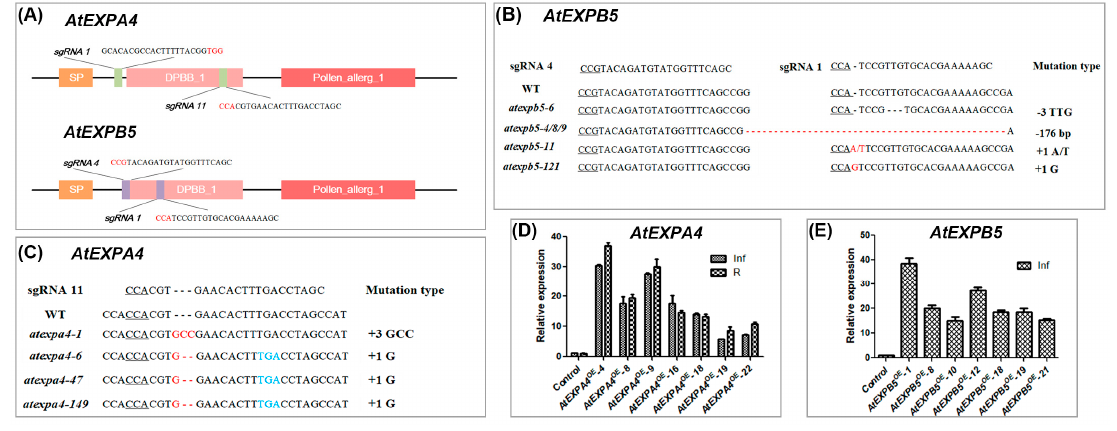
Figure 3. Confirmation of AtEXPA4 and AtEXPB5 transgenic plants. ( A ), Genomic location of sgRNAs targeting to AtEXPA4 and AtEXPB5 . PAM sites are highlighted in red. ( B , C ), the gene editing situation of AtEXPA4 and AtEXPB5 by CRISPR/Cas9 system in T 3 plants. Underlined letters, red letters, and blue letters represent PAM sites, gene editing sites, and stop codons, respectively. ( D ), qRT-PCR analysis of AtEXPA4 expression in AtEXPA4 OE lines. 35-d-old roots (R) and inflorescences (Inf). BETA-TUBULIN4 was used as the reference gene. AtEXPA4 expression in control lines were normalized to 1. ( E ), qRT-PCR analysis of AtEXPB5 expression in AtEXPB5 OE lines. 35-d-old inflorescences (Inf). BETA-TUBULIN4 was used as the reference gene. AtEXPB5 expression in control lines were normalized to 1. The values are the mean ± SD, three biological replicates with three technical replicates in each biological